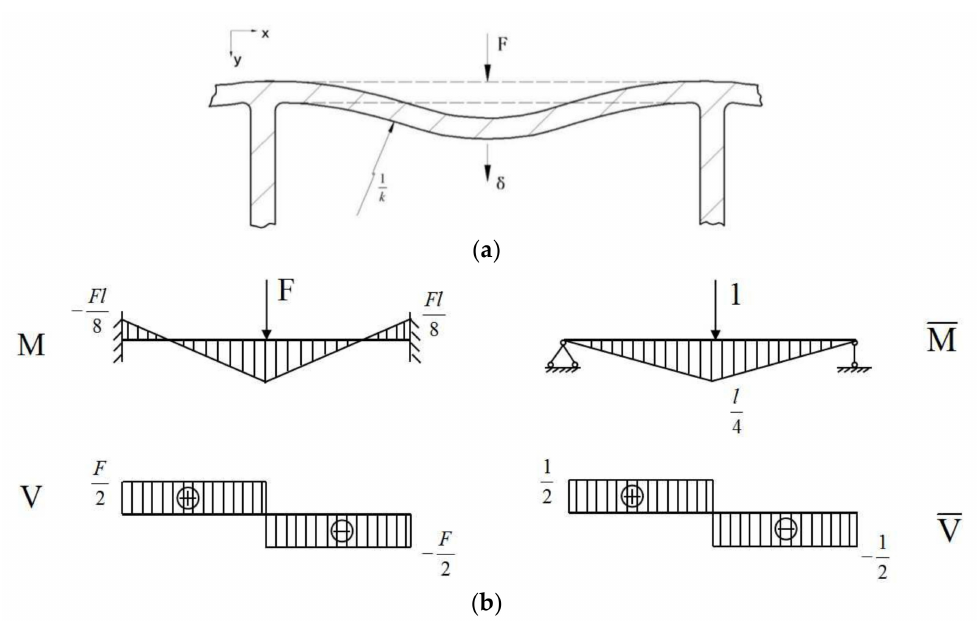
Figure 13. Stress analysis of the interlocking grid structure panel. ( a ) Stress and deformation diagram of pane; ( b ) stress decomposition diagram of